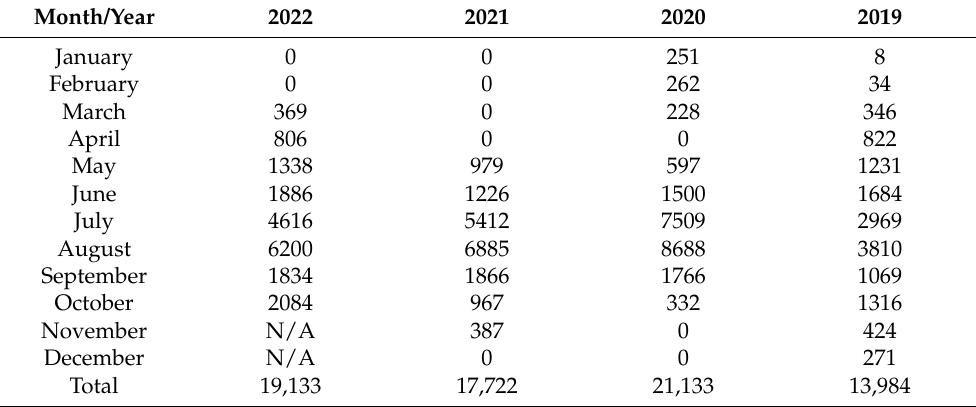
Table 3. Numbers of visitors in the Jozef adit (source: internal material of Slovenske Opalove Bane).